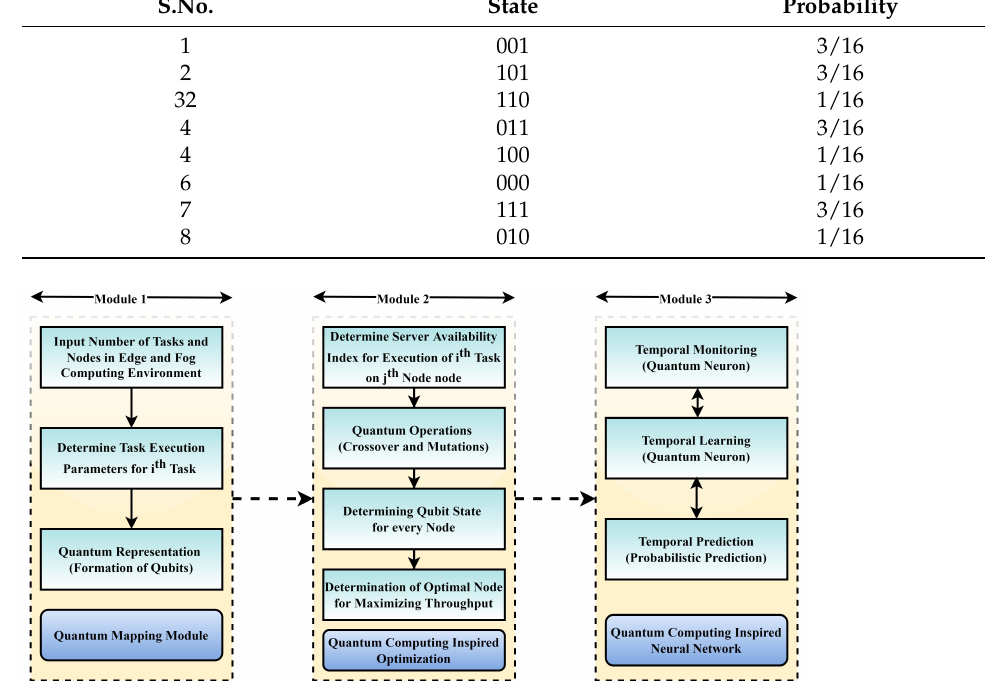
Figure 3. Proposed